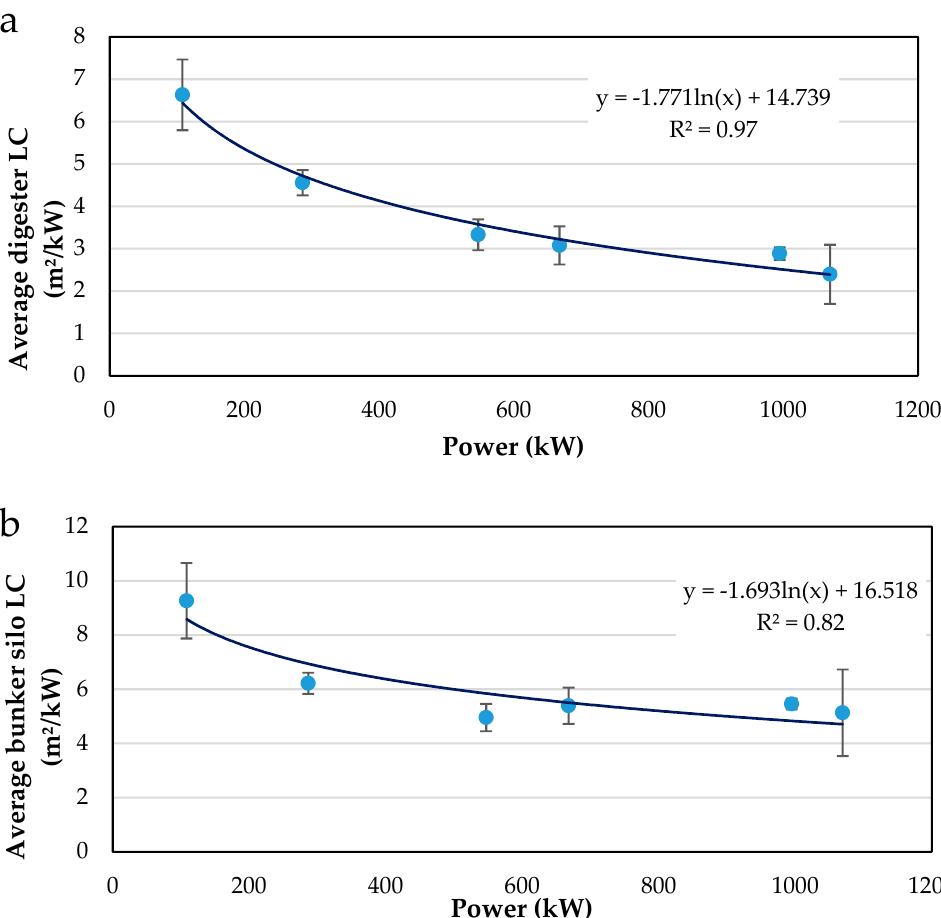
Figure 9. Relation between installed power and average digester LC ( a ) and average bunker silo LC ( b ).